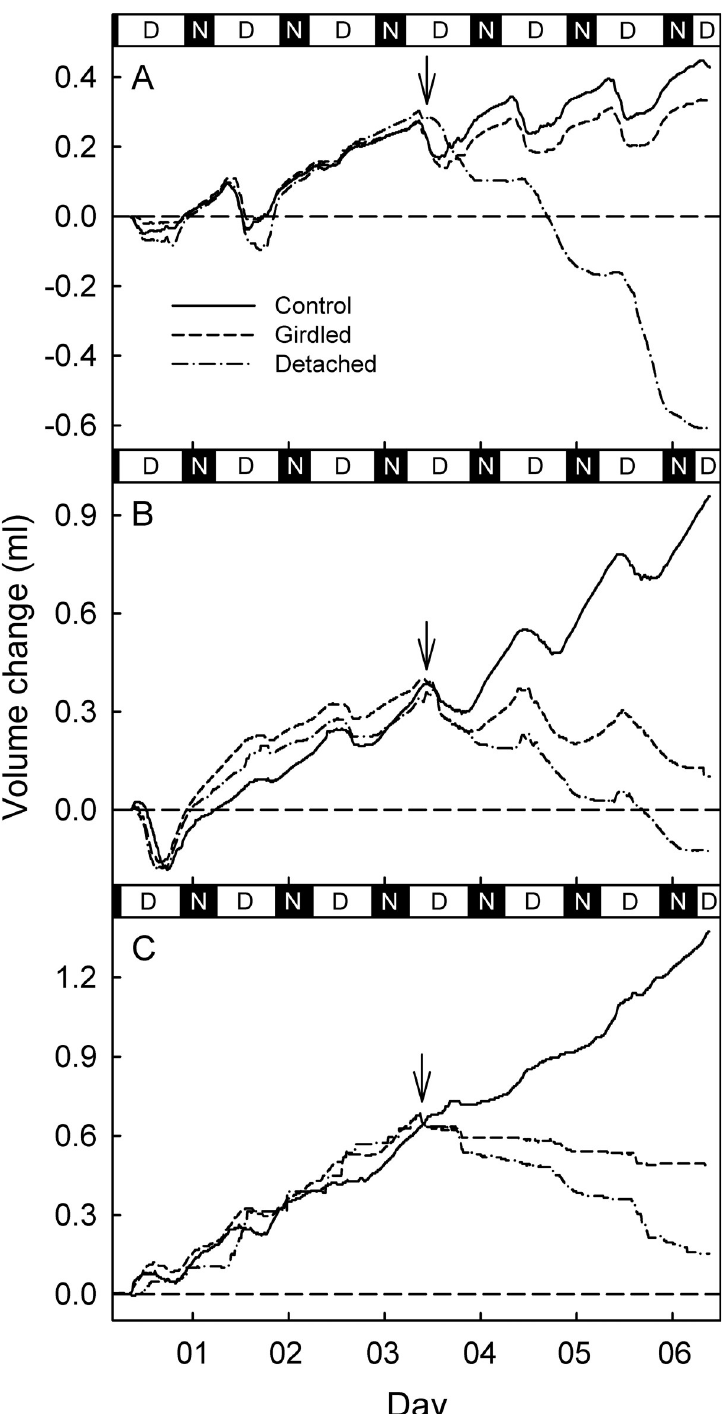
Fig 2. Typical weekly time courses of change in fruit volume calculated from changes in the three orthogonal diameters of European plum fruit during stage II at 75 days after full bloom (DAFB) (A), in early stage III (103 DAFB) (B) and in late stage III (132 DAFB) (C). In the morning of the fourth day (indicated by arrow), fruit pedicels were steam-girdled (dashed line) or detached (dashed and dotted line), but all fruit remained in situ in the canopy. Un- treated fruit served as controls for comparison. Data are for a single fruit representative for the steam-girdled, detached and control treatments. D and N on the x -axis indicate day (light) and night (dark) periods.